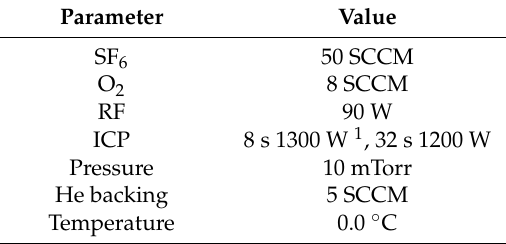
Table 2. ICP-RIE anisotropic recipe used to etch the sub-micron channel in silicon.